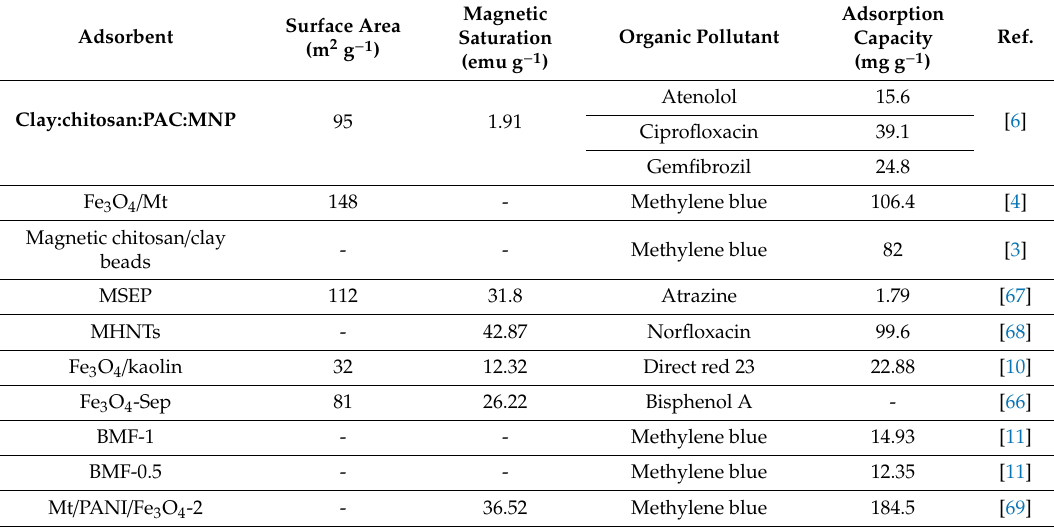
Table 2. Application of magnetic clay-based nanoadsorbents for organic pollutants’ removal from water.